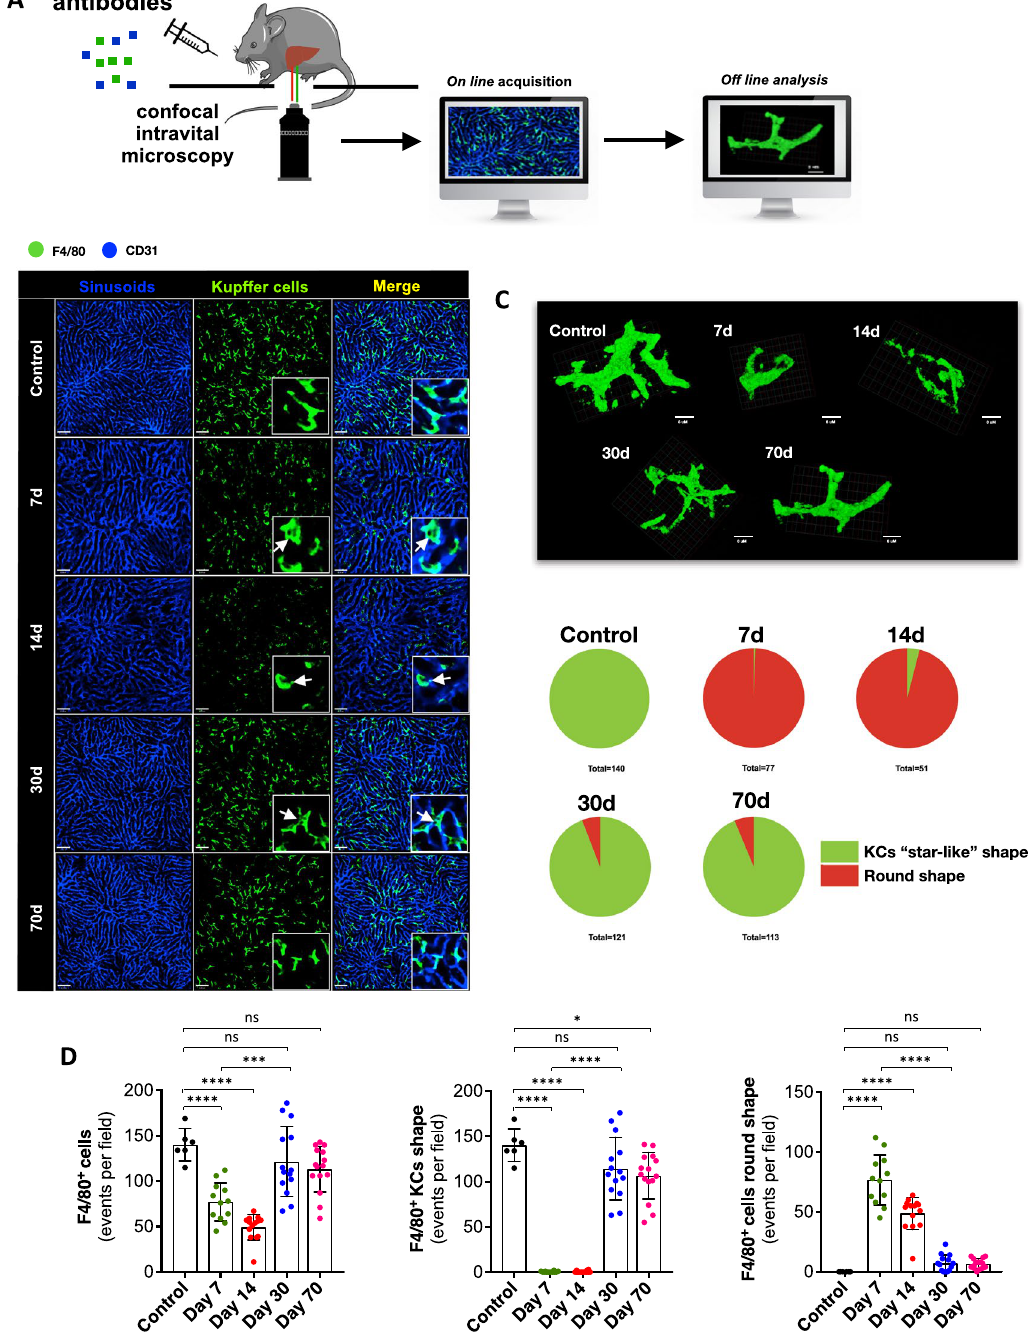
Figure 4. Liver Kupffer cells visualized in vivo during P. chabaudi infection. ( A ) Schematic representation of assessment of liver Kupffer cells (KCs) by intravital microscopy (IVM). The scheme was partly generated using Sevier Medical Art, provided by Sevier, licensed under a Creative Commons Attribution 3.0 unported license. ( B ) Liver IVM evidencing the distribution of F4/80 + cells (Kupffer cells; anti-F4/80; green) in days 7, 14, 30 and 70 post infection. ( C ) Three-dimensional reconstruction of individual KCs followed by quantification. ( D ) Digital quantification of total F4/80 + cells, F4/80 + Kupffer “star-like” shape and F4/80 + round shape cells. The data shown are representative of 3 independent experiments. Results expressed as mean ± SD. Statistical significance comparing infected and non-infected mice (one-way ANOVA *** p < 0.001, **** p <